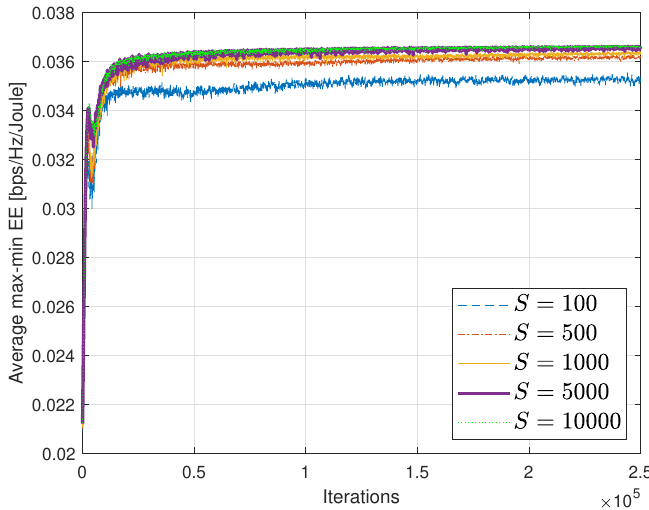
Figure 6. Convergence of validation performance with K = 4, P C = 33 dBm, and P = 30 dBm for different S